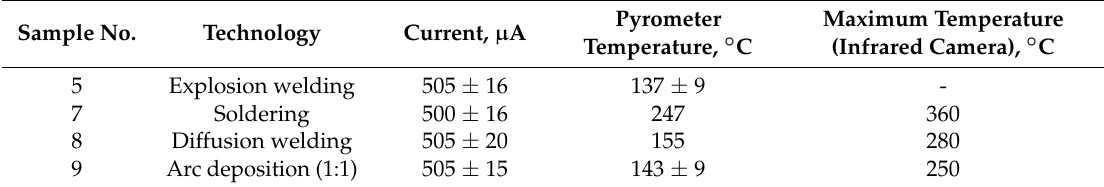
Table 2. Temperature of samples of tantalum foil welded to